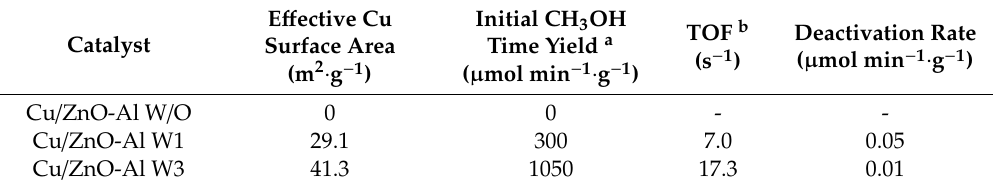
Figure 7. Transmission electron microscopy (TEM) micrographs of reduced catalysts: ( a.1 , a.2 ) Cu/ZnO-Al-W/O, ( b.1 , b.2 ) Cu/ZnOAl-W1, ( c.1 , c.2 ) Cu/ZnO-Al-W3. Table 3. Effective Cu surface area (N 2 O chemisorption) and activity data in methanol synthesis from syngas (initial methanol yield, TOF (turnover overall frequency) and deactivation rate (decay in umol CH 3 OH/min gcat) of reduced catalysts.